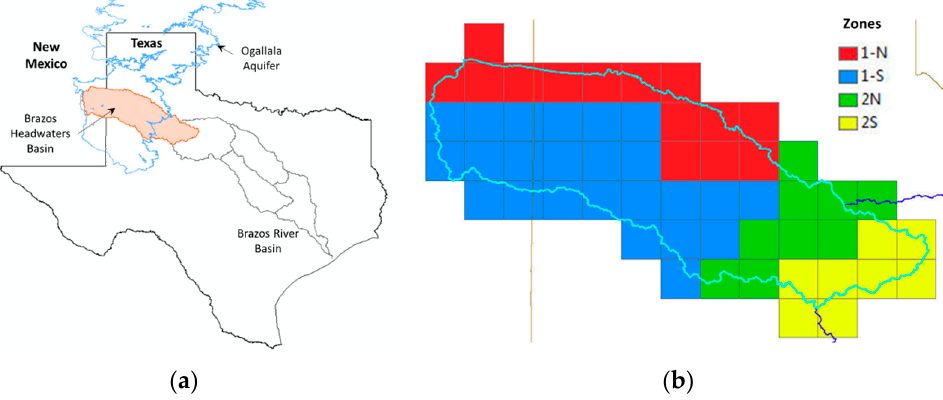
Figure 1. Map of the state of Texas with ( a ) location of the Brazos Headwaters Basin and ( b ) NCEP-CFSR grid cells and Texas Agricultural Statistical Districts (1-N, 1-S, 2-N, and 2-S) covering the Brazos Headwaters Basin.